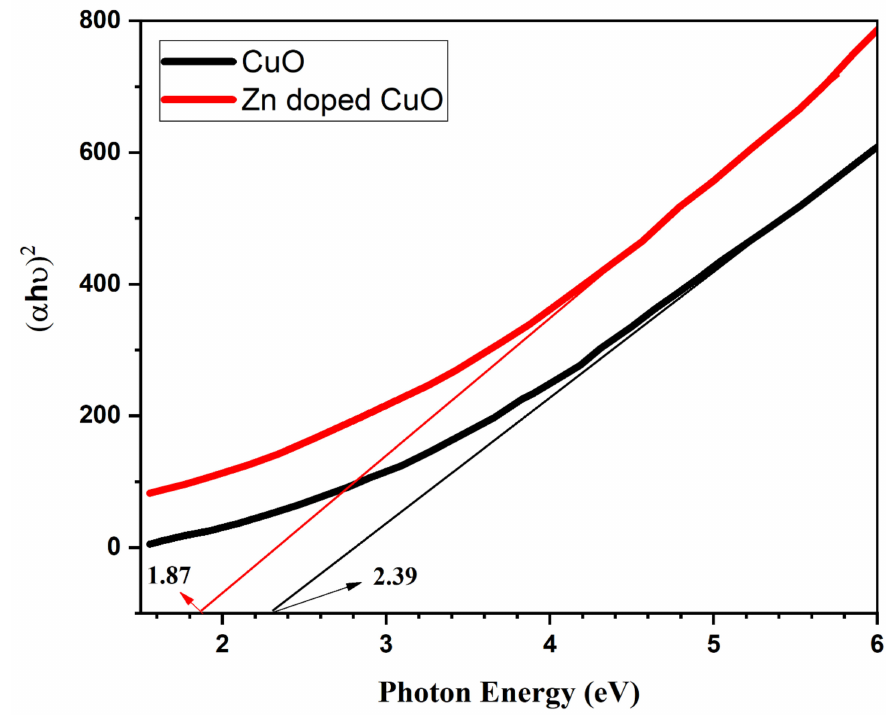
Figure 7. Band gap absorption edges of CuO and Zn-doped CuO